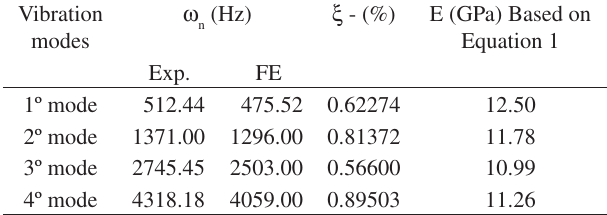
Table 2. Dynamical characteristics estimated for the HLM graphite